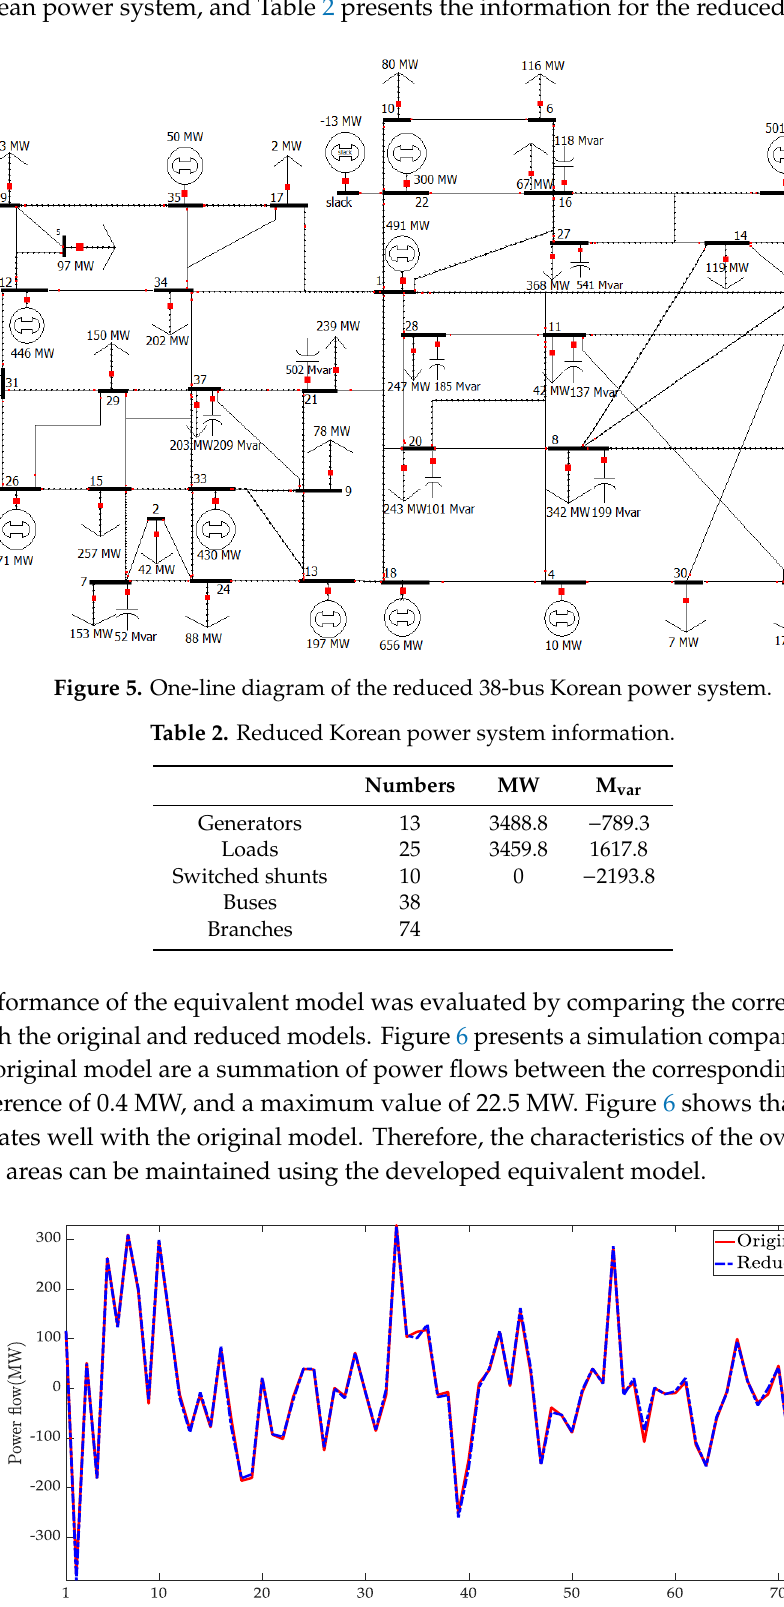
Figure 6. Comparison of real power flows over transmission lines.